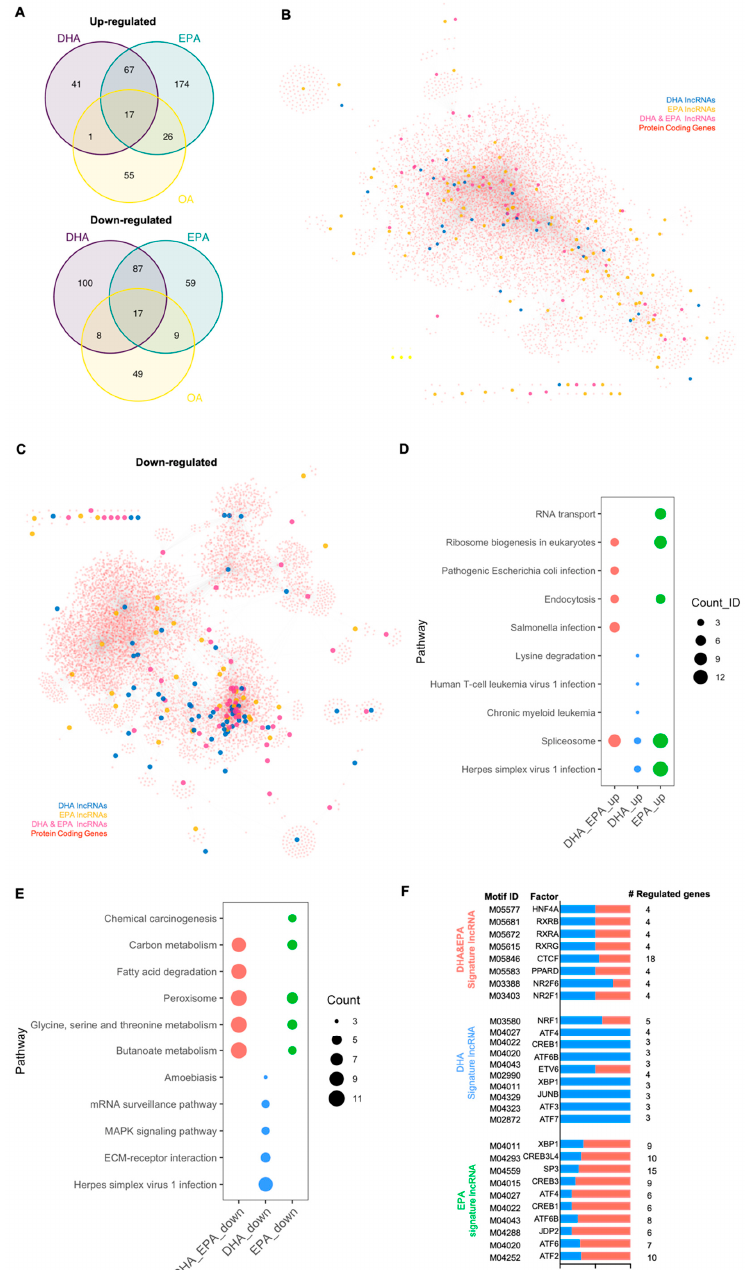
Figure 3. Define signature lncRNA genes responsive to DHA/EPA supplementation. ( A ) Define signature lncRNA genes by intersection of DHA, EPA, or OA responsive lncRNAs. ( B , C ) lncRNA- mRNA co-expression network analysis to infer the potential functions of signature lncRNA genes. Networks were constructed with upregulated ( B ) or downregulated ( C ) signature lncRNAs and their strongly correlated hepatic protein coding genes (Pearson cor |R| > 0.6, p value < 0.05). ( D , E ) Top KEGG pathways mostly enriched by each category of upregulated ( D ) and downregulated ( E ) signature lncRNAs. Specifically, pathway enrichment analysis was performed for each signature lncRNA based on their correlated protein coding genes. The resultant pathways with enrichment score ( p value < 0.05) were subsequently counted to calculate the top 5 most enriched representative pathways. ( F ) Transcription factor binding motifs enriched in DHA, EPA-specific or DHA and EPA commonly regulated signature lncRNA